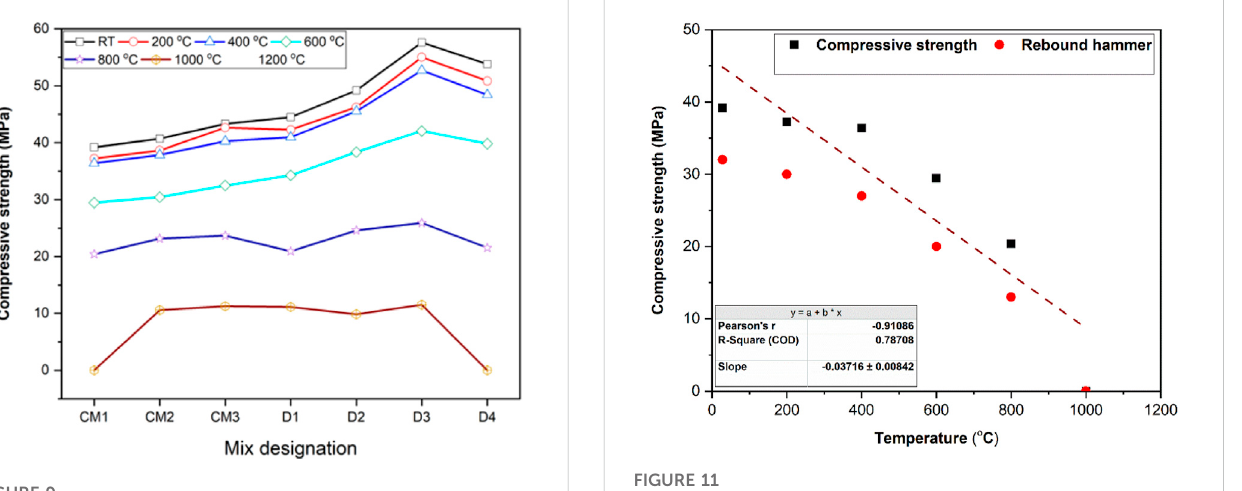
FIGURE 9 Compressive strength of control and dolerite mixes as function of temperature.